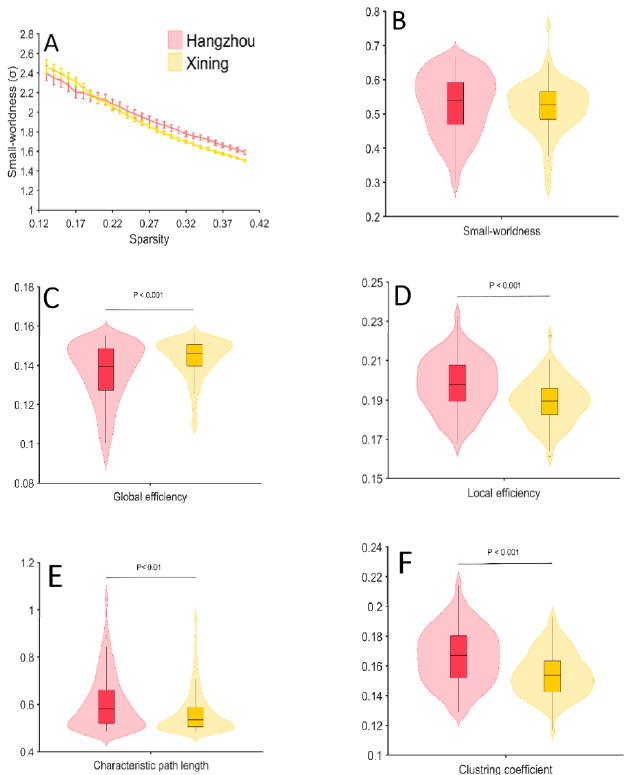
Figure 5. Group differences in the network properties between the two groups. ( A ) The small-worldness quantified from the Hangzhou (red) and Xining groups (yellow). ( B – F ) Group differences in the small-worldness, global efficiency, local efficiency, characteristic path length and clustering coefficients between Hangzhou and Xining groups.